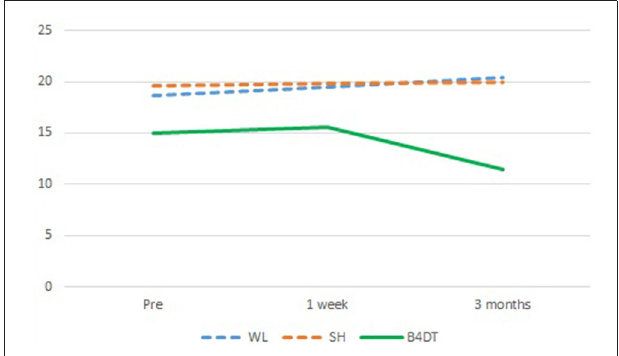
FIGURE 1 | Insomnia scores for the three treatment conditions ( n = 48) from pre-treatment to 3 months after starting intervention. The B4DT group